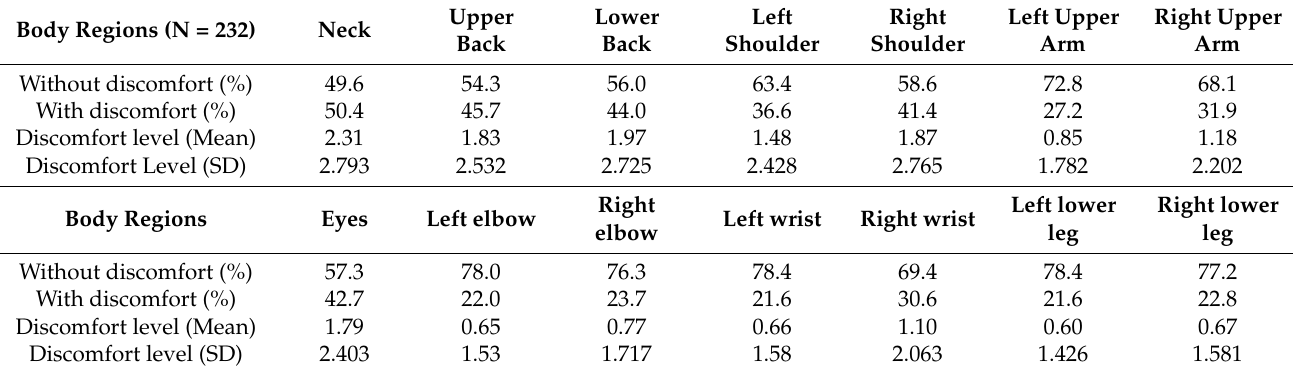
Table 1. The prevalence rate of work-related musculoskeletal discomfort of homeworkers among 14 body regions.